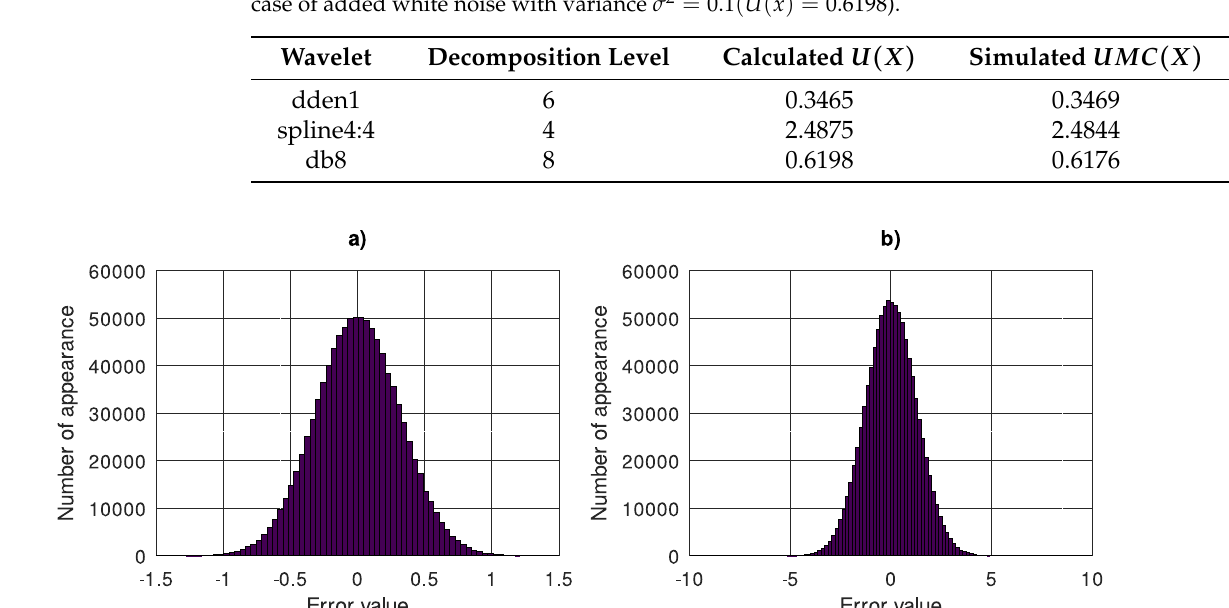
Table 2. Examples of the output uncertainty values ( U ( X ) —calculated; UMC ( X ) —simulated) in the